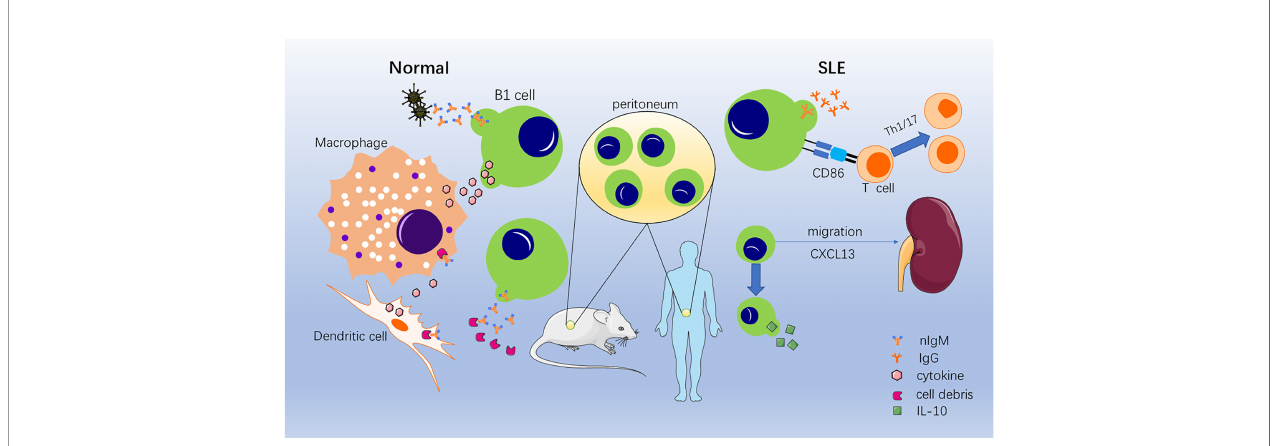
FIGURE 1 | Role of B1 cells under normal conditions and systemic lupus erythematosus (SLE) conditions. In normal situations, B1 cells secrete nIgM binding invading pathogenic bacteria and necrotic and apoptotic cellular components. Then, phagocytosis and clearance are accelerated, and cytokines are secreted to activate macrophages and dendritic cells. In SLE conditions, B1 cells convert to secrete self-reactive IgG; promote the conversion of T cells to Th1/17 cells; migrate to the kidney, thymus, and spleen; and secrete